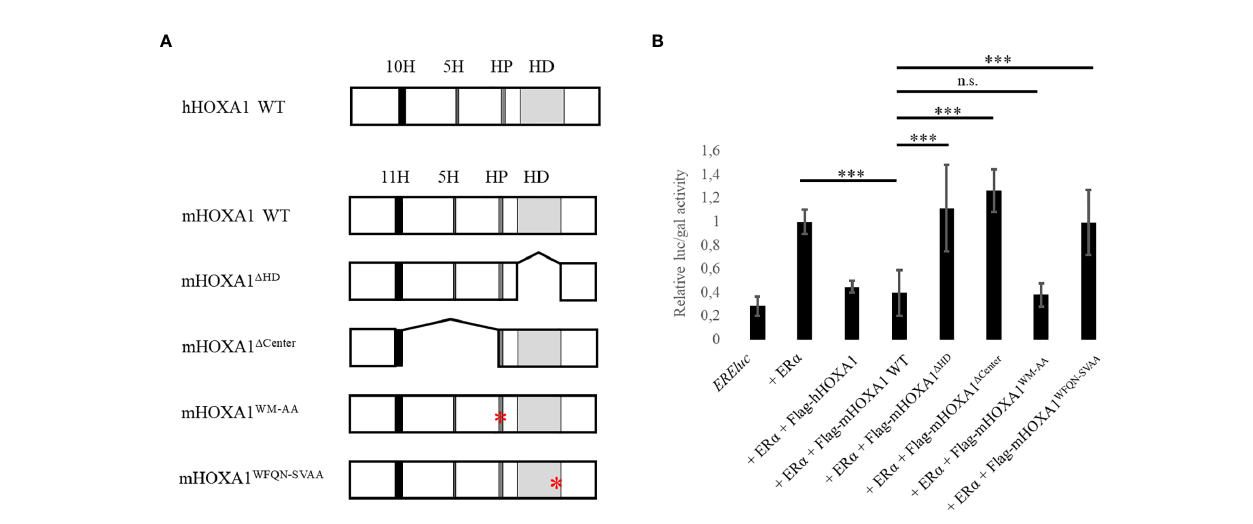
FIGURE 4 | Map of HOXA1 variants and their impact on ER a activity. (A) hHOXA1 WT (336 amino acids) encompasses two histidines stretches of ten (10H) and fi ve amino acids (5H), a hexapeptide (HP) and a homeodomain (HD) of sixty amino acids structured in three a -helices. mHOXA1 WT (331 amino acids) shares 94,7% identity with hHOXA1 WT. A major difference is the length of the fi rst histidine tract showing eleven amino acids in the mouse. mHOXA1 D HD is deprived of the homeodomain, responsible for the loss of DNA binding. mHOXA1 D Center lacks the 129-amino acid sequence between the fi rst histidine repeat and the hexapeptide. mHOXA1 WM-AA shows a mutation in the sequence of the hexapeptide, perfectly conserved between the human and mouse proteins and changed from TFDWMK to TFDAAK, which implies the loss of PBX interaction. mHOXA1 WFQN-SVAA harbours a mutation in the third a -helix of the homeodomain, which impairs DNA binding. (B) Impact of HOXA1-derivatives on the ER a transcriptional activity. MCF10A cells were transfected with plasmids encoding EREluc, ER a , Flag-hHOXA1, Flag- mHOXA1 WT, Flag-mHOXA1 D HD , Flag-mHOXA1 D Center , Flag-mHOXA1 WM-AA , Flag-mHOXA1 WFQN-SVAA and b -galactosidase under the control of a CMV promoter. ER-mediated luciferase activity (luc) was reported to the b -galactosidase activity (gal). Activation of the ER reporter by ER a is reduced in the presence of Flag- hHOXA1 and Flag-mHOXA1 WT. This effect is lost with the deletion or the mutation of the homeodomain, as well as upon the deletion of the central part of the protein. Mutations in the hexapeptide does not affect the ability of HOXA1 to inhibit ER a (N=3, n=2). n.s. means test result not signi fi cant (p > 0.05), *** means p < 0,001. Error bars represent standard deviation, for N experiments and n replicates per